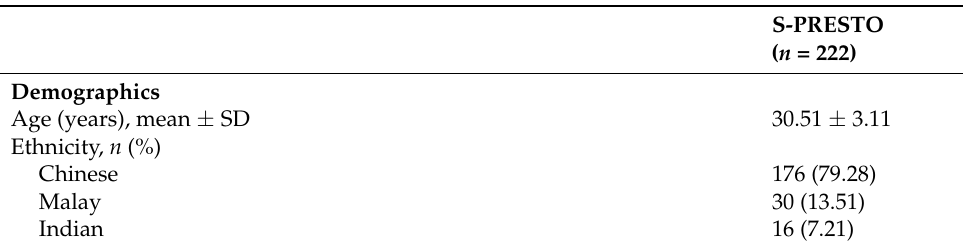
Table 1. Participant characteristics at preconception baseline. Participant characteristics table on demographics, medical/obstetric history, physical measures, blood-derived markers, lifestyle factors, metabolic indices, prediabetes status, antenatal OGTT and adverse birth outcomes. Continuous variables are presented as group mean value and standard deviation. Categorical variables are presented as count and